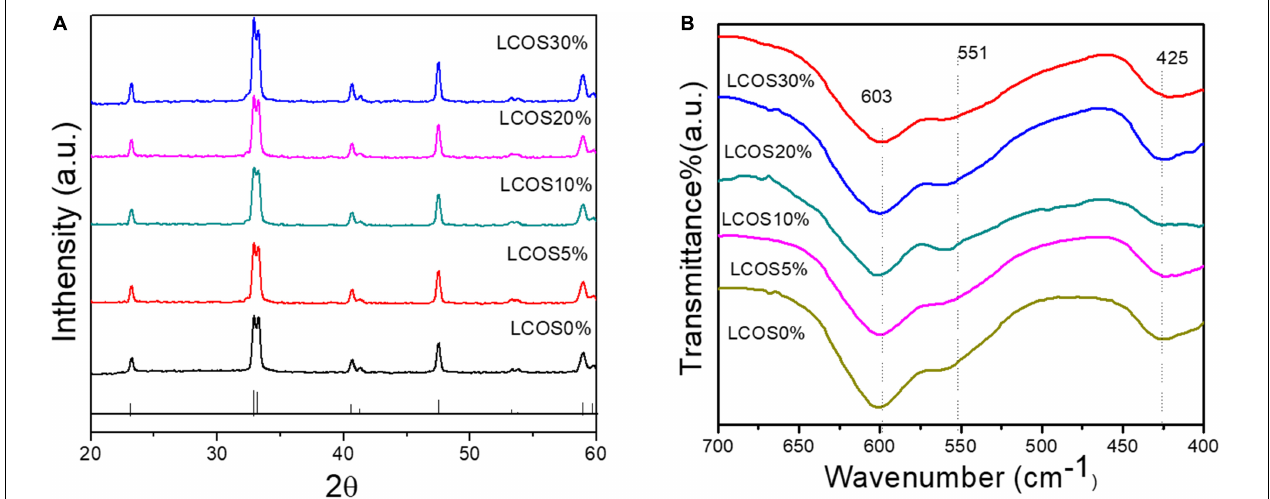
FIGURE 1 | (A) Powder XRD patterns and (B) FTIR spectra of the LSCO0%, LSCO5%, LSCO10%, LSCO20%, and LSCO30% samples. The pattern shown at the bottom of (A) is the standard pattern (JCPDS # 251060) of LCO with a tetragonal crystal structure.